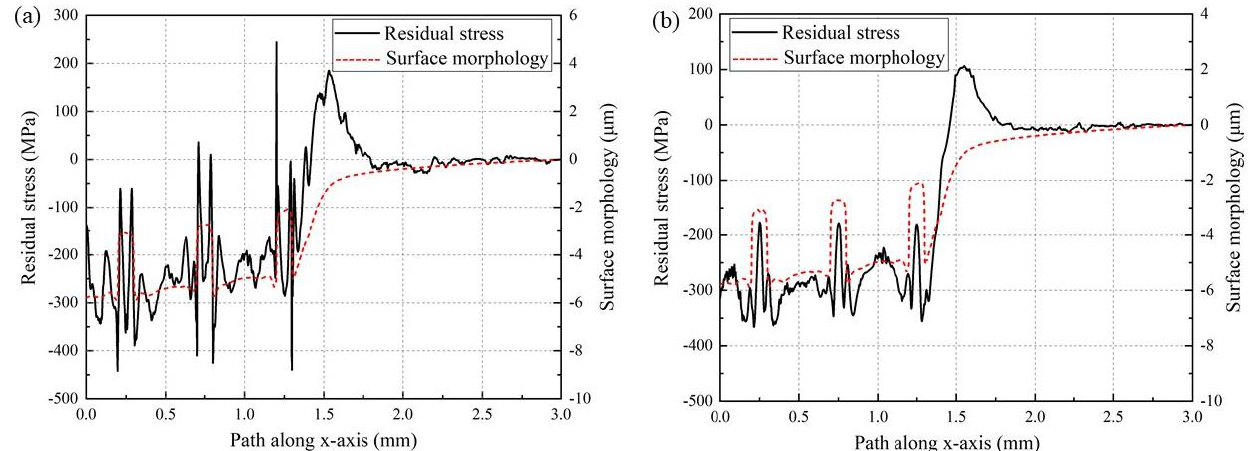
Figure 9. Residual stress distribution on the sample surface ( a ) and residual stress distribution at a depth of 20 μm below the surface ( b ), under a peak pressure of 5 GPa.